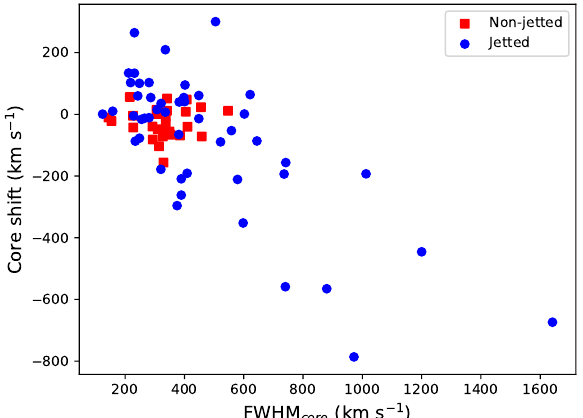
Figure 4. Correlation between the FWHM of the [O III] core component and its shift. Non-jetted sources are represented with the red squares, while jetted sources are indicated with the blue circles.